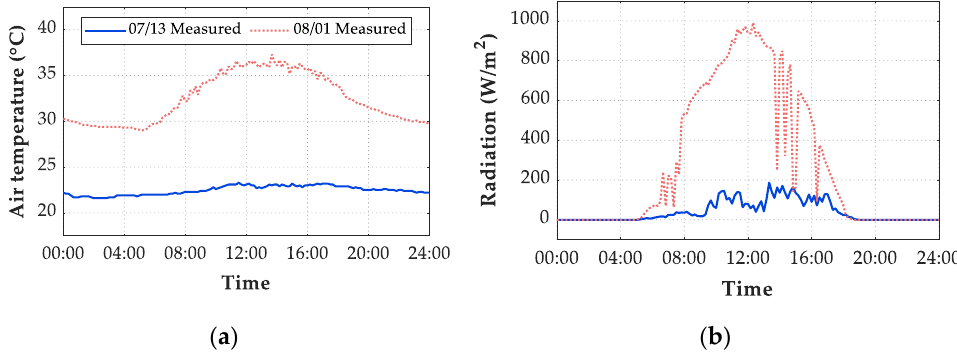
Figure 18. Time variation of meteorological data during one day. ( a ) Air temperature; ( b ) total solar radiation on the ground.